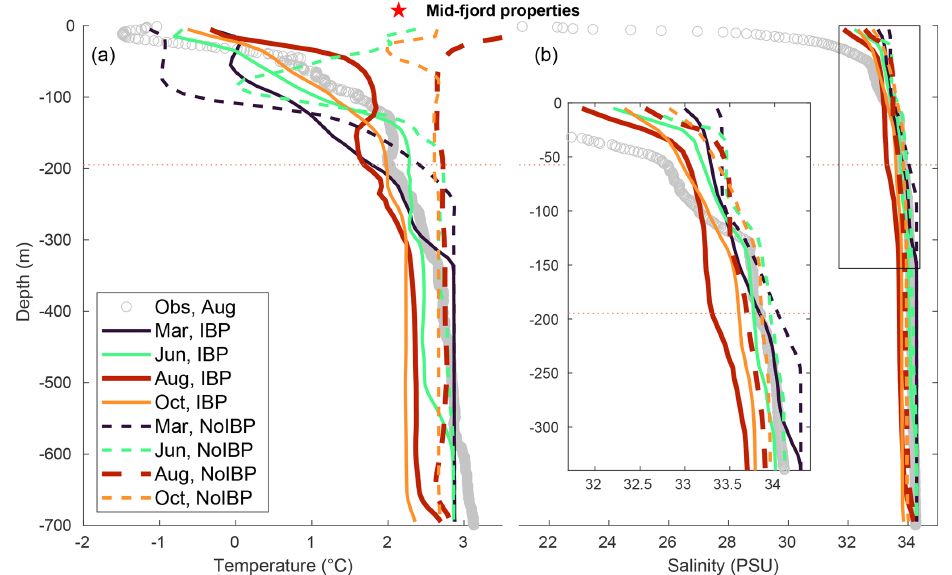
Figure 8. Mid-fjord temperature and salinity profiles for March (winter), June (early season), August (peak season) and October (late season) for both IBP (solid lines) and NoIBP (dashed lines). Grey circles indicate the XCTD profiles in August 2014 (Beaird et al., 2017). The dotted horizontal line marks 195m depth, which coincides in IBP with isopycnal 26.5kgm − 3 and the inflow–outflow border in August and in the observations with isopycnal 26.9kgm − 3 . The mid-fjord location is indicated with a red star and vertical dotted lines in Figs. 3 and 1 and as an outlined red star in Fig.